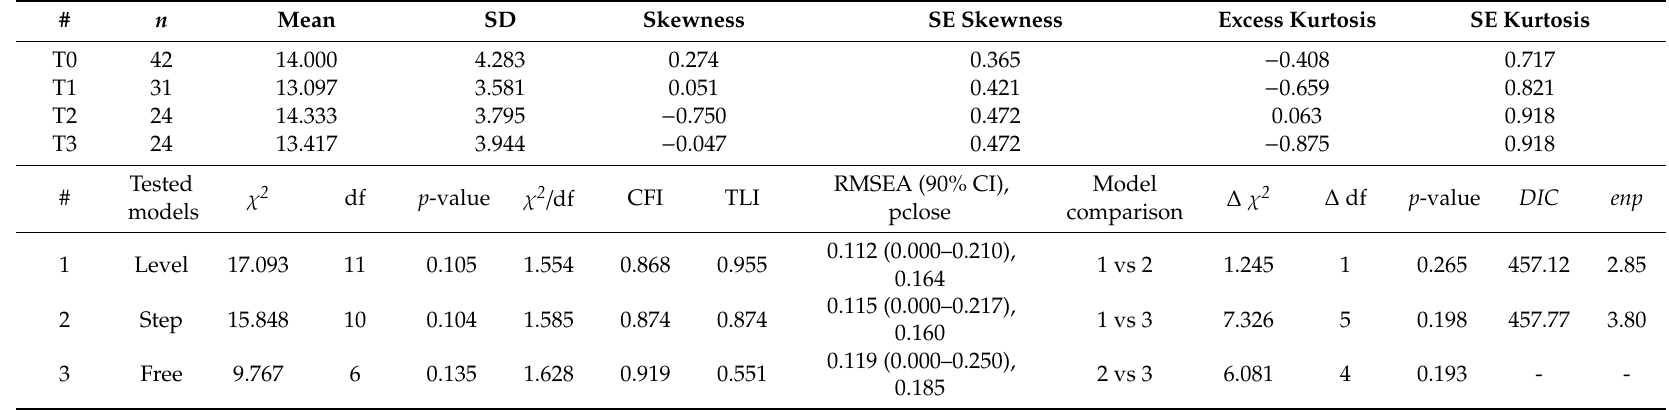
Table 3. Comparisons of latent growth curve models estimating growth trajectory for a cyclical representation of PD over an 18-month follow-up